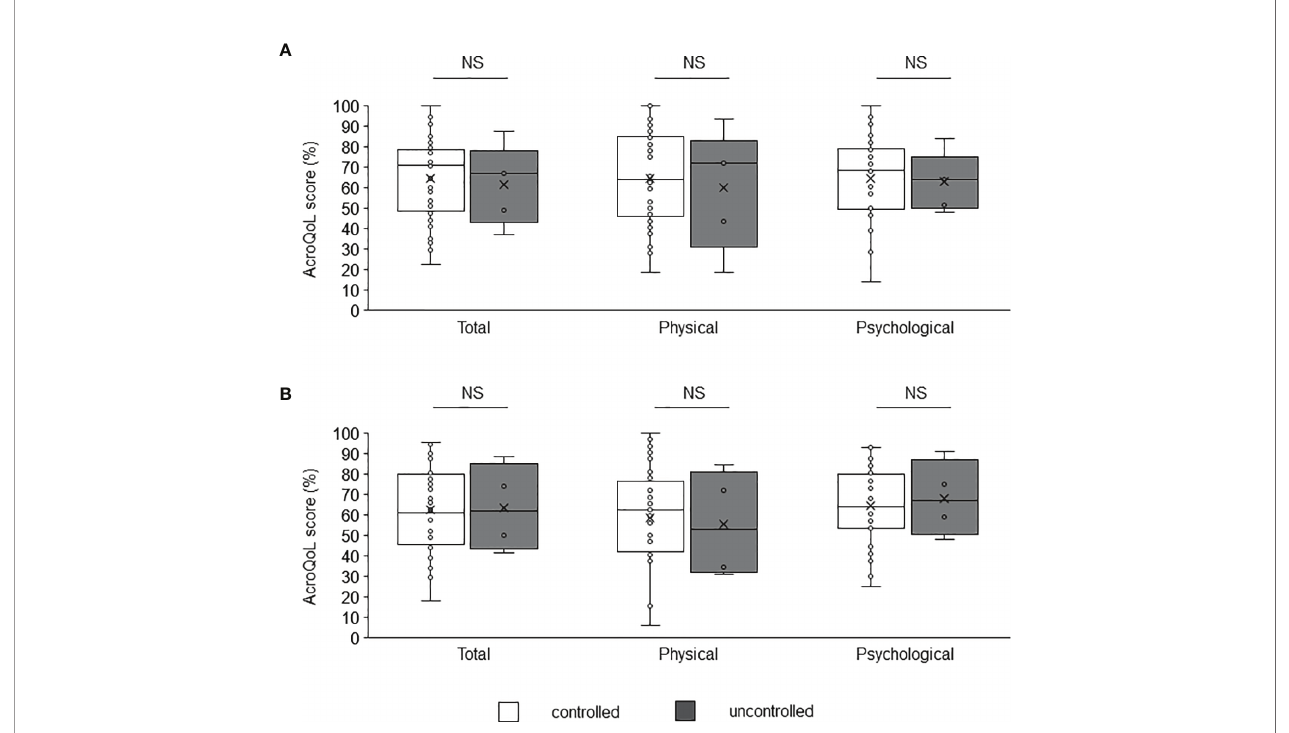
FIGURE 2 | Comparison of AcroQoL scores of the subgroups based on the disease control status. Comparison of AcroQoL scores of the subgroups based on the disease control status in the (A) young and middle-aged, and (B) older groups. Patients with random GH levels of <1.0 ng/mL and IGF-I SDS of <2.0 are considered controlled, and others are considered uncontrolled. Individual scores have been plotted, and median values and interquartile ranges are shown in the box plot. NS, not signi fi